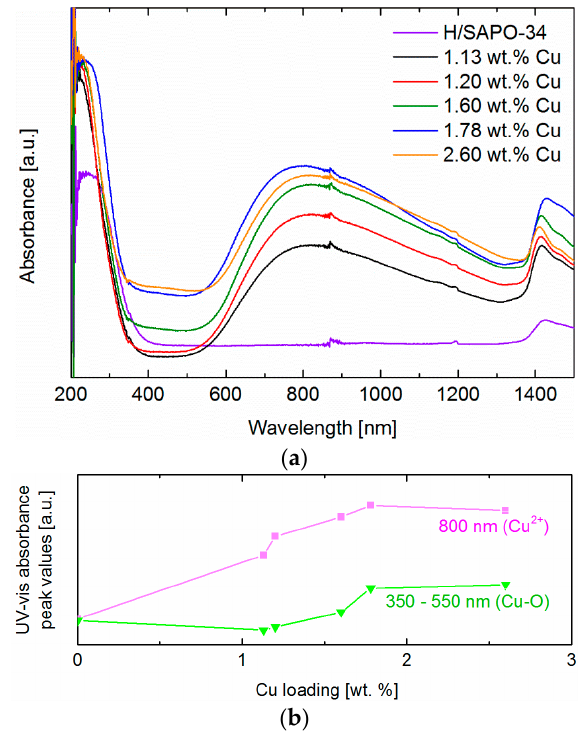
Figure 2. UV-vis data for Cu/SAPO-34 catalysts. ( a ) UV-vis spectra of Cu/SAPO-34 catalysts with different Cu loadings; ( b ) UV-vis absorbance band intensities as a function of Cu loading.